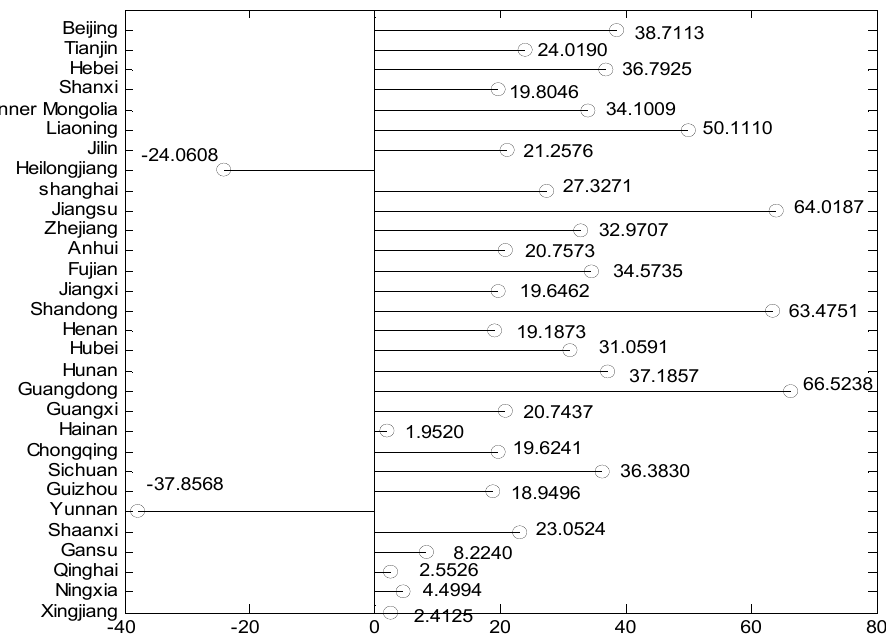
Figure 3. The contribution of provincial carbon productivity to China’s carbon productivity.